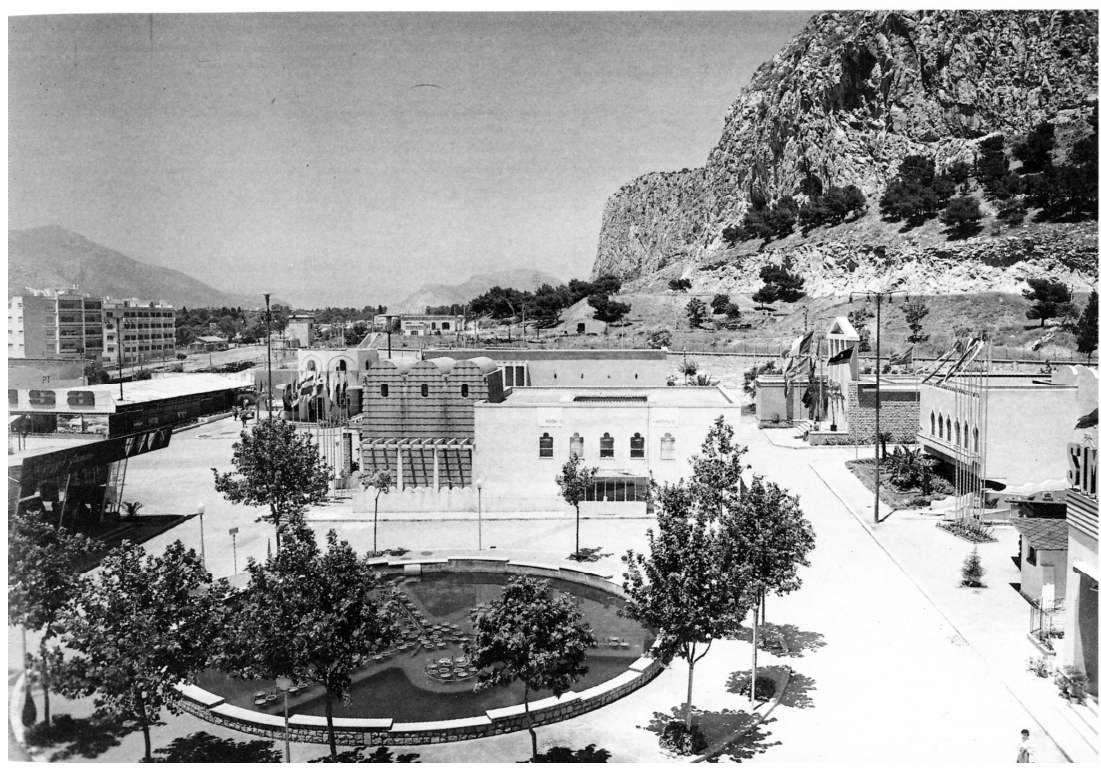
Figure 2. Pavilions area for the Mediterranean